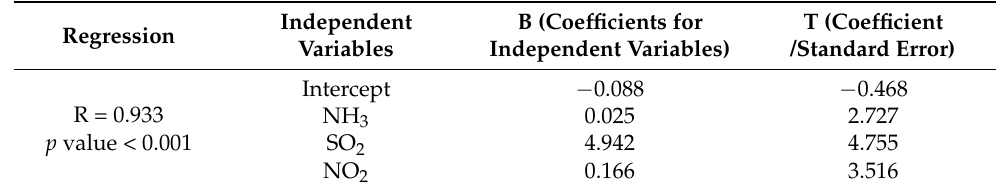
Table 2. Multivariate linear regressions between barn PM 2.5 emission rate (dependent variable) and its precursor gas emission rates from the barns.